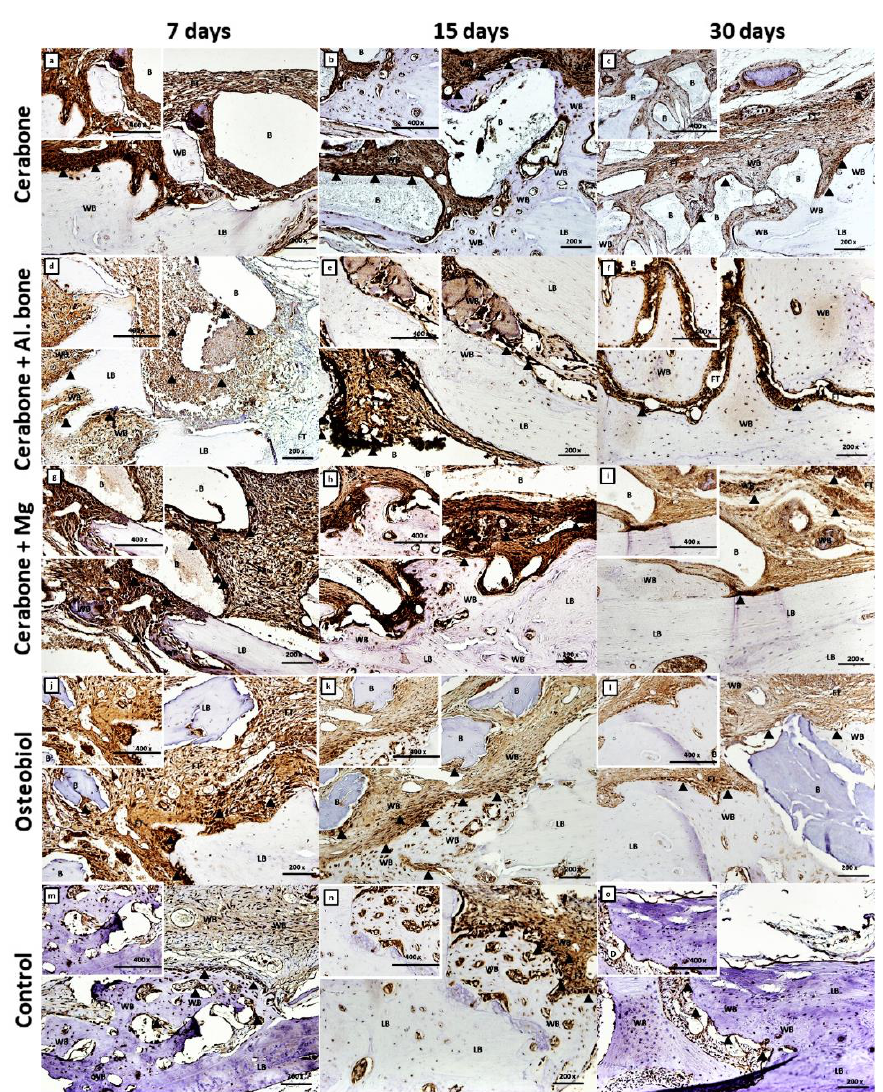
Figure 4. Tumor necrosis factor-alpha (TNF- α) immunohistochemical staining of the coronal sec- tions of rat calvarial bone defects implanted with different biomaterials: Cerabone ® ( a – c ); Cerabone ® + Al. bone ( d – f ); Cerabone ® + Mg ( g – i ); Osteobiol ® ( j – l ), and control ( m – o ). For each group of im- planted biomaterial, three representative time points (7th, 15th, and 30th days after implantation) were chosen to show temporal and spatial localization of TNF- α in rat calvarial defects (magnifica- tion 200 × , microphotography in the left upper corner, magnification 400 × ). The arrowheads ( ▲ ) in- dicate cells with strong TNF- α expression.